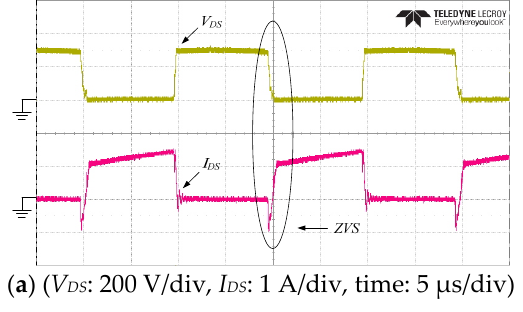
Figure 20. Measured switch voltage V DS and current I DS of the proposed hybrid converter operated in the utility line condition under 45% of the full-load condition: ( a ) switch M 1 and ( b ) switch M 2 .